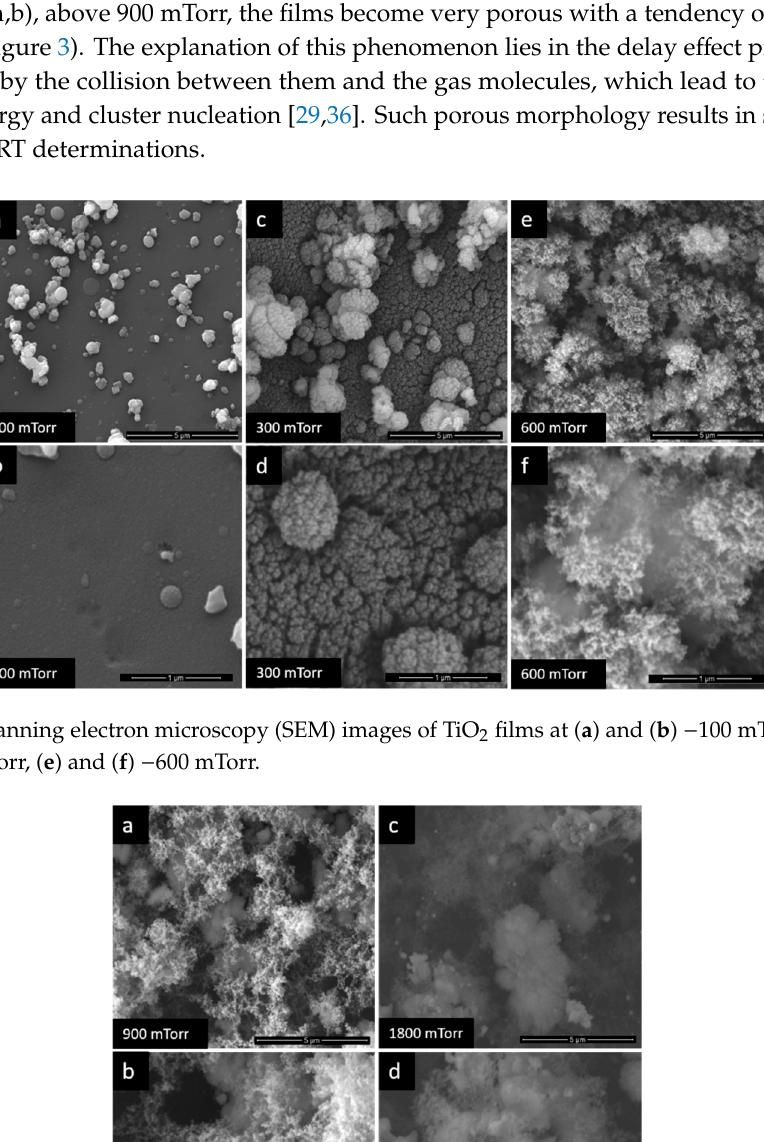
Figure 1. Experimental setup for surface acoustic wave (SAW) sensor frequency shift measurements for hydrogen detection [29] .